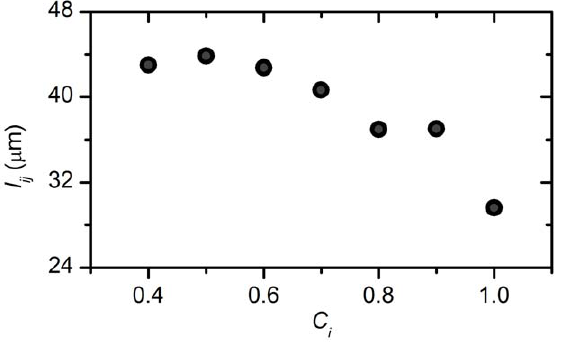
Figure 7. Average length of links as a function of the local clustering coefficient. Plotted are the values obtained for the HG regime.